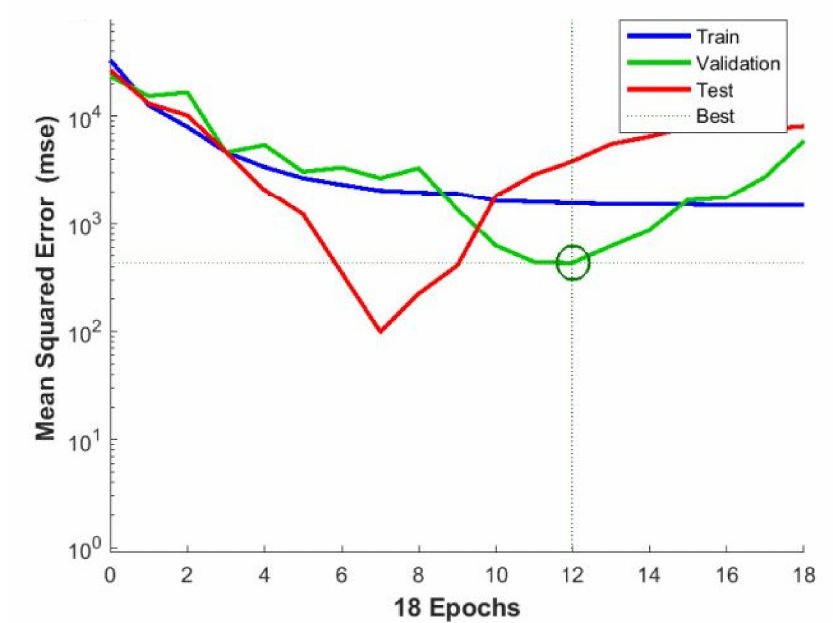
Figure 4. Performance of the neural network showing